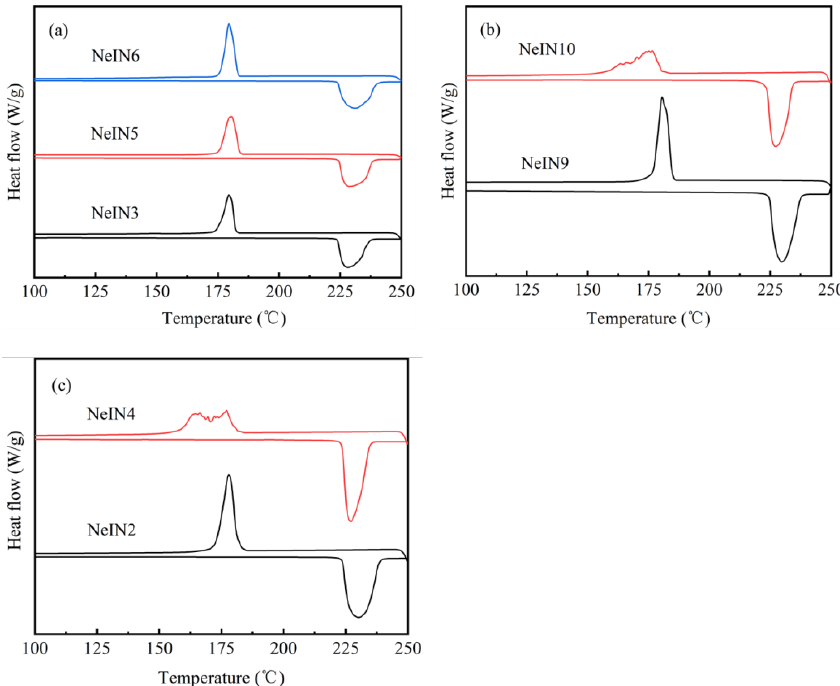
Figure 7. DSC curves of the nanocapsules with various conditions: ( a ) NeIN3, NeIN5 and NeIN6; ( b ) NeIN9 and NeIN10; ( c ) NeIN2 and